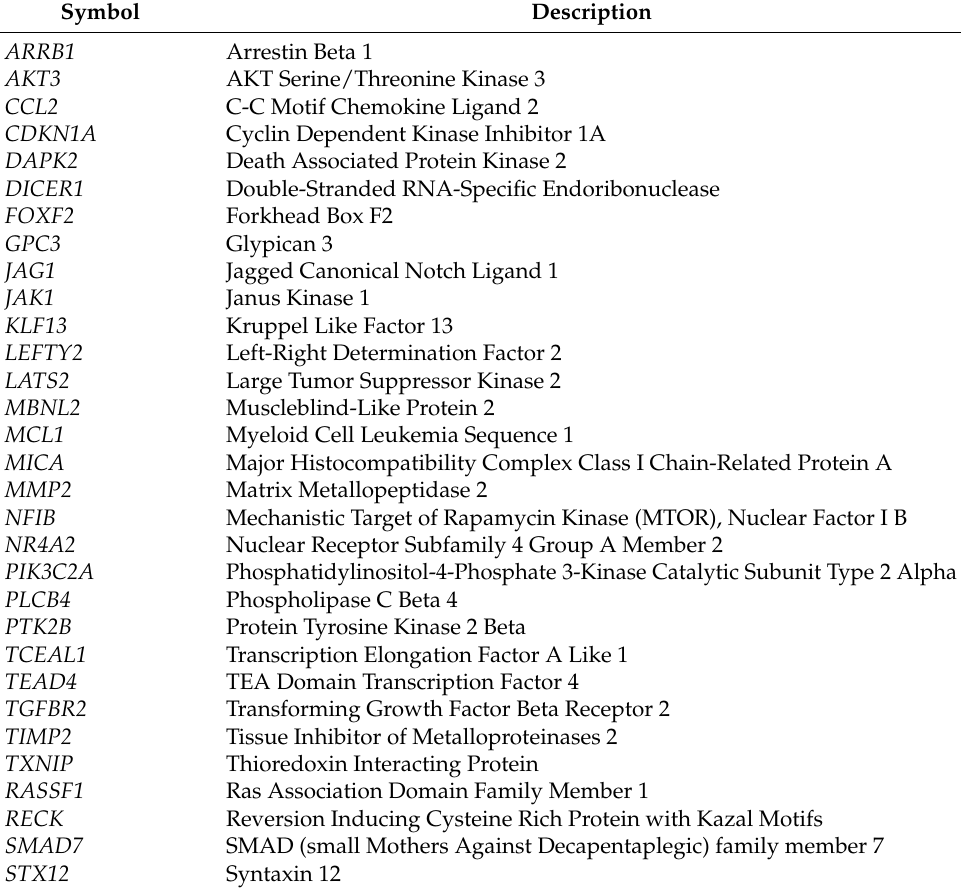
Table 3. Target genes with significant expression differences in NSCLC tissue compared to normal lung